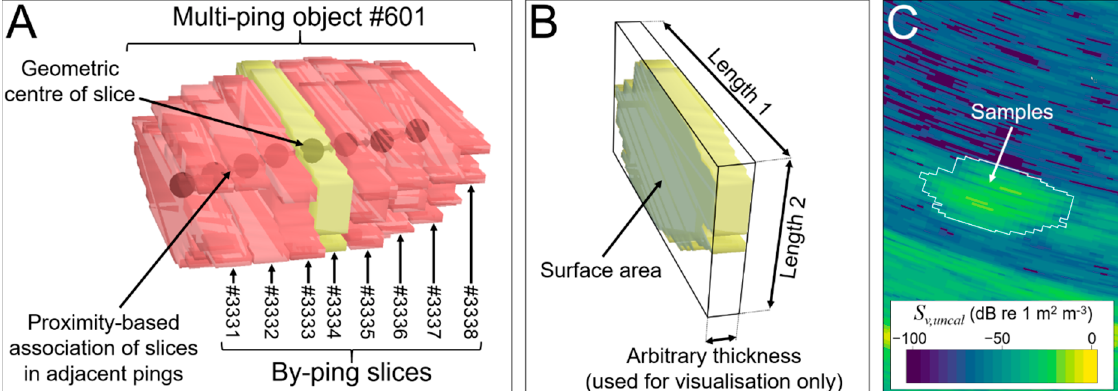
Figure 6. The geometry of slices and multi-ping objects. ( A ) A 3D object such as a fish school or a cluster of bubbles from a gas seep was conceived as a sequence of backscattering cross-sections (“slices”) delineated across multiple pings. A slice detected in one ping was associated with a slice in the next ping (black spheres joined by arrows) based on spatial proximity by applying a tracking algorithm more commonly used for following the movement of an object through space and time. ( B ) 3D view of slice #3334 in ( A ). ( C ) 2D echogram view of slice #3334 in ( A ).